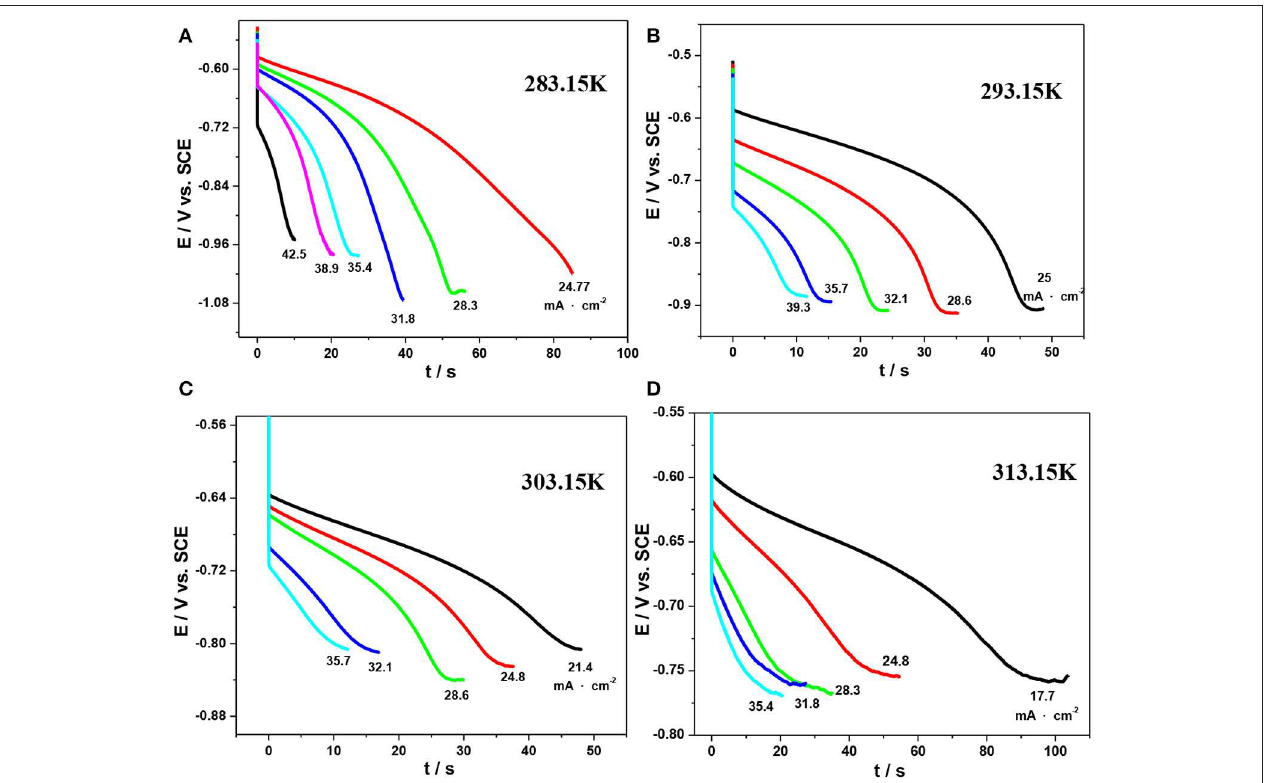
FIGURE 9 | Chronopotentiograms for the reduction reaction of V(III) on an SPGR in 1.0 mol · L − 1 V(III) with 2.0 mol · L − 1 H 2 SO 4 at various temperatures: 283.15K (A) , 293.15K (B) , 303.15K (C) , and 313.15 K (D) .